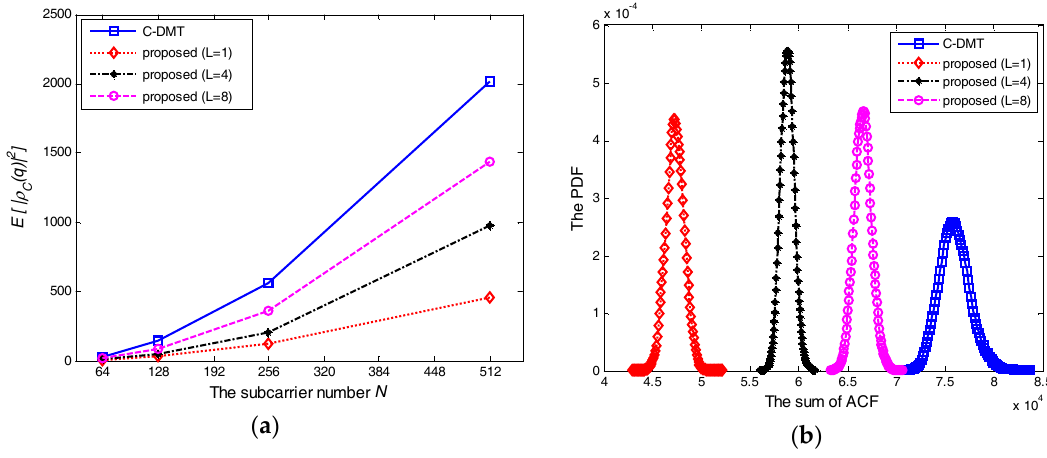
Figure 7. CCDF performance comparison: ( a ) E probability density functions (PDFs) of aperiodic autocorrelation function (ACF) performance comparison (for 512 subcarrier with 4000 discrete multi-tone (DMT) symbols).